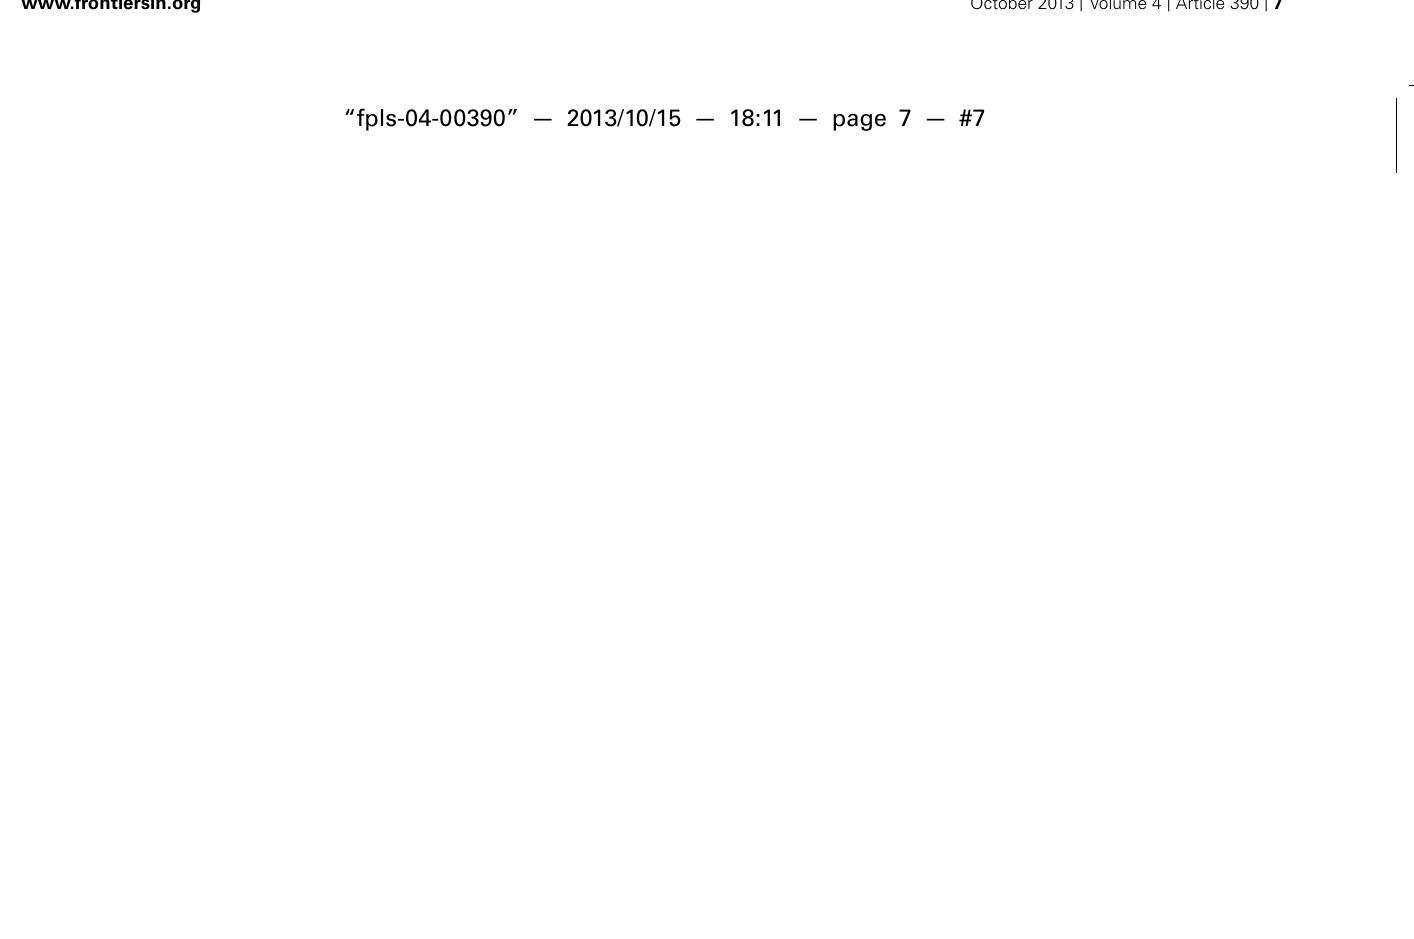
reductase enzymatic capacity measured using HPLC in crude leaf extracts using dabsyl-MetO, a synthetic substrate mimicking peptide-bound MetO. Data are mean values ± SD from at least five independent measurements per genotype. **Significantly different fromWt with p < 0.01 ( t -test). (E) Western analysis of catalase abundance. SimilarWestern data were obtained using leaf extracts from two independent plants originating from at least two distinct growth experiments.Wt, wild-type;Trx f + andTrx m + , plants overexpressingTrx f orTrx m,